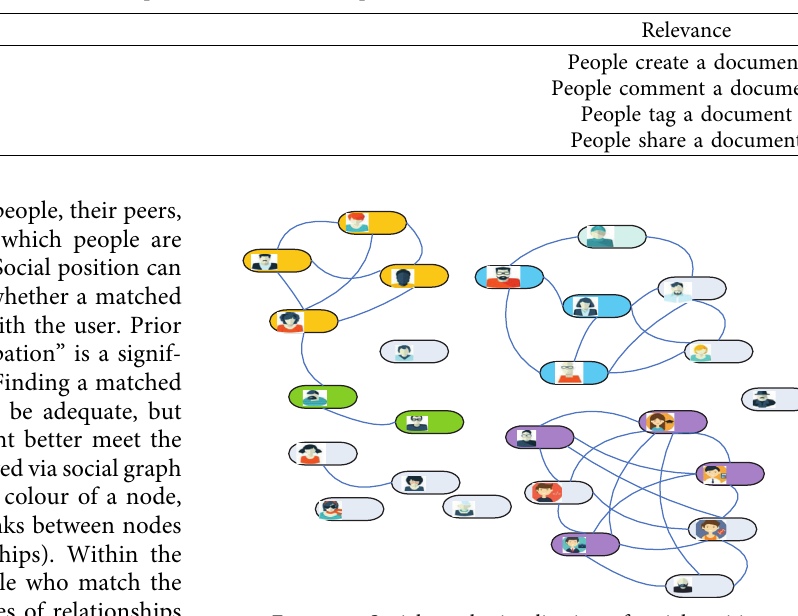
Table 3: People-resource relationships.